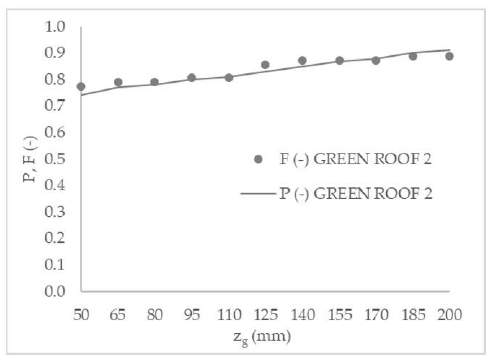
Figure 3. Comparison between probability ( P ) and frequency ( F ) distribution function of water content into growing medium varying its thickness ( z g ), GREEN ROOF 2.